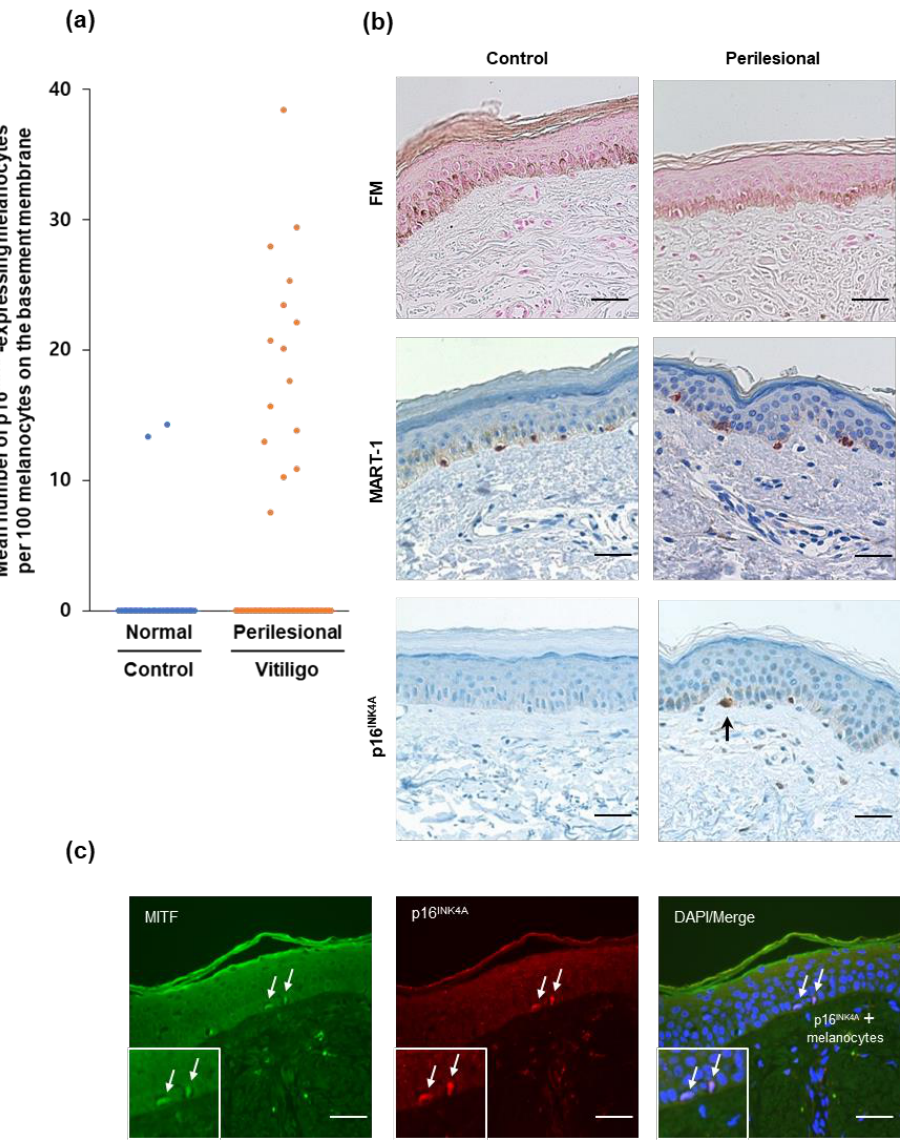
Figure 1. Number of p16 INK4A -positive melanocytes in the perilesional epidermis of NSV patients and in normal control skin samples: ( a ) P16 INK4A -positive melanocytes were quantified per 100 melanocytes on the basement membrane of a skin specimen. Data are expressed the mean ± SE, n = 54 patients with NSV, n = 33 normal control donors; p = 0.0023 according to a Student’s t -test. Raw data are available in Table S1 and S2. ( b ) The amount of melanin was similar between NSV patients and normal controls. The melanocyte marker, MART1, showed no significant difference in melanocytic density count. A p16 INK4A -positive melanocyte (arrow) is shown in the perilesional epidermis of NSV patients (scale bar, 100 μm). ( c ) Representative immunofluorescence reactivity of the p16 INK4A antibody in NSV. MITF (green)/p16 INK4A (red) double-immunostained melanocytes (arrows) are visualized.